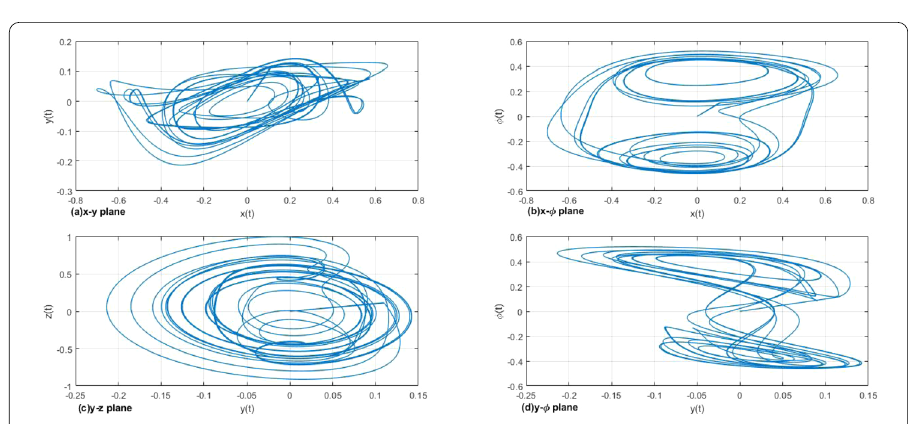
Figure 3 Phase portrait of model (21) for q = 0.99 projected on different